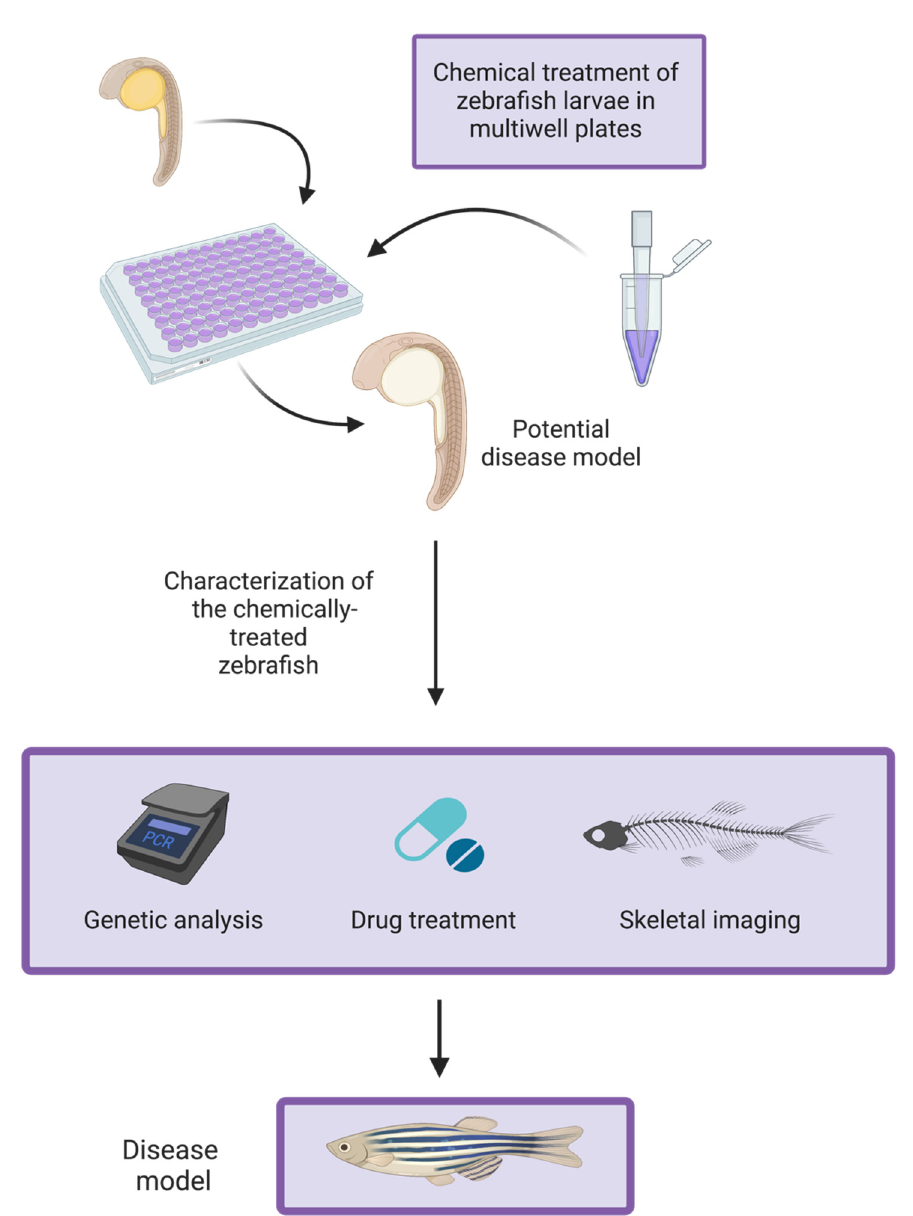
Figure 1. Schematic representation of a protocol to develop a zebrafish model for secondary OP using chemical treatments. Zebrafish larvae are placed in multiwell plates containing a dissolved chemical agent (e.g., glucocorticoids). The phenotype of the chemically-treated zebrafish is then characterized using a variety of approaches, including genetic analysis (e.g., via quantitative reverse transcription-polymerase chain reaction), skeletal imaging and drug treatments. Treatment of a candidate disease model with a drug designed to treat said condition in humans allows for the clinical relevance of the model to be evaluated. Information obtained from Barrett et al. (2006) [40], Huang et al. (2018) [44] and Zhang et al. (2018) [46]. Created with BioRender.com. Another strength of the zebrafish model system is the ability to characterize skeletal phenotypes in vivo. As zebrafish embryos and larvae are optically transparent, fluorescent reporter lines (such as the Tg(ola.sp7:nlsGFP) mutant line) [49] can be used to visualize the zebrafish skeleton in real time. Fluorescent vital stains (such as calcein) [41,50] also provide the ability to conduct skeletal imaging in live zebrafish, and the use of transparent zebrafish of the casper strain enables such fluorescent imaging to be conducted in adult fish [51]. In the context of drug discovery, fluorescent imaging provides the ability to more rapidly